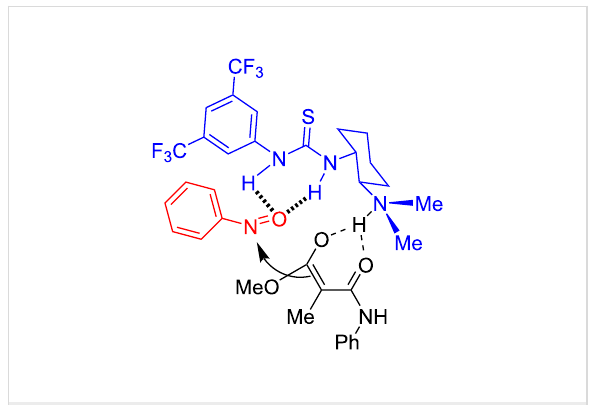
Figure 2: Proposed transition state for the nitroso aldol